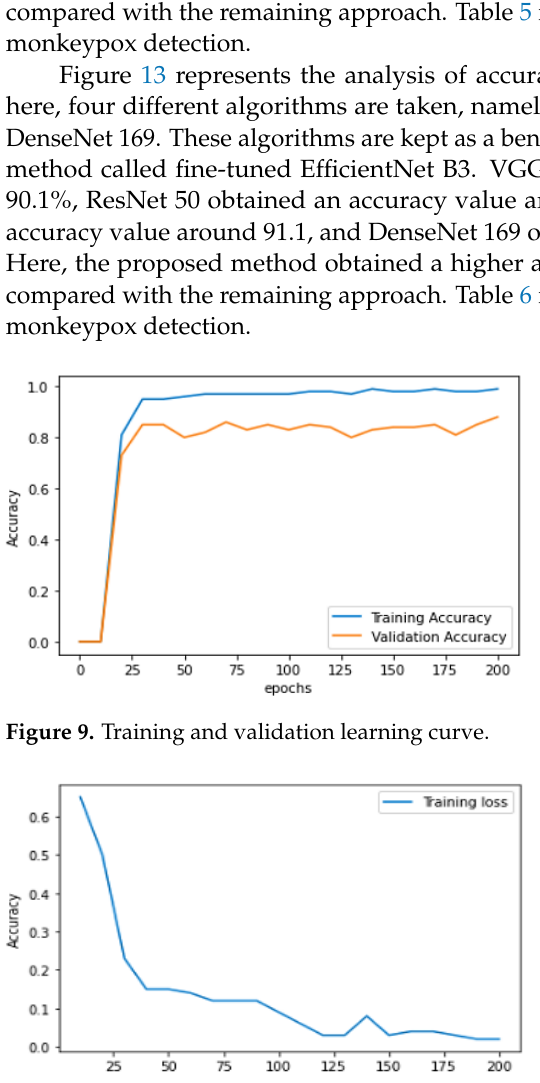
Figure 10. Training loss learning curve.